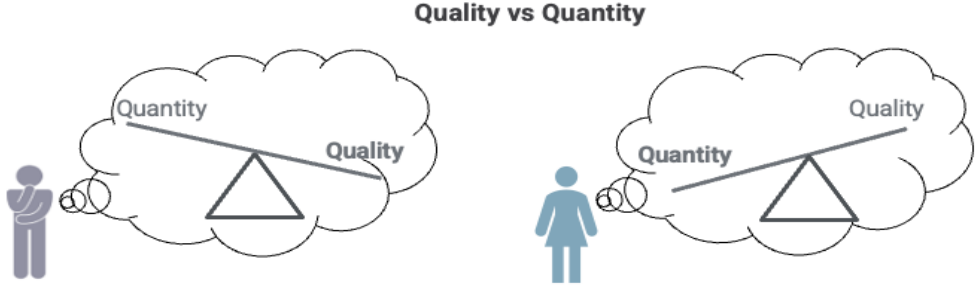
Figure 2. Bill (in grey) values underlying health domains differently compared to others (lack of metric invariance).